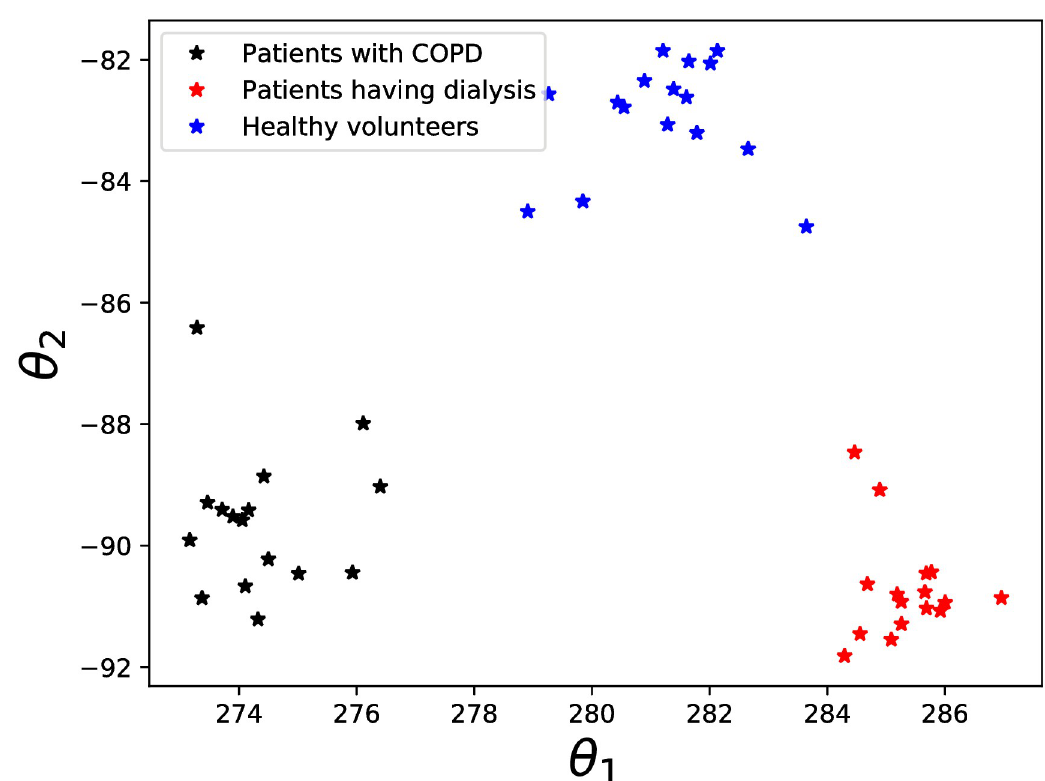
Fig 8. Discriminative projection of parameter space. The discriminative projection of the parameter space learned from the MAP estimates, in which the patients with COPD, patients having dialysis and healthy volunteers were accurately clustered illustrating that we do not lose any discriminative information inherent in the patient dataset while learning the MAP estimates.